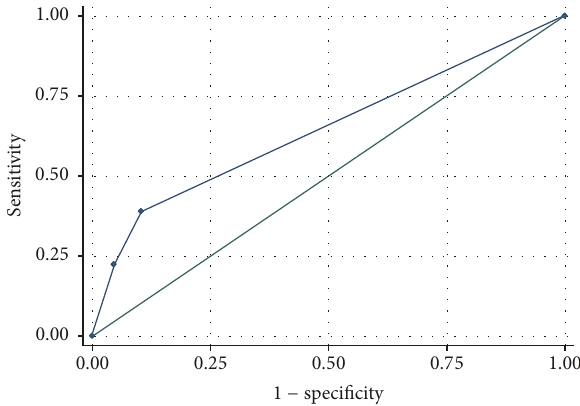
Figure 1: A receiver operating characteristic (ROC) curve of Glasgow Coma Scale and intracranial hemorrhage in patients with moderate risk of mild head